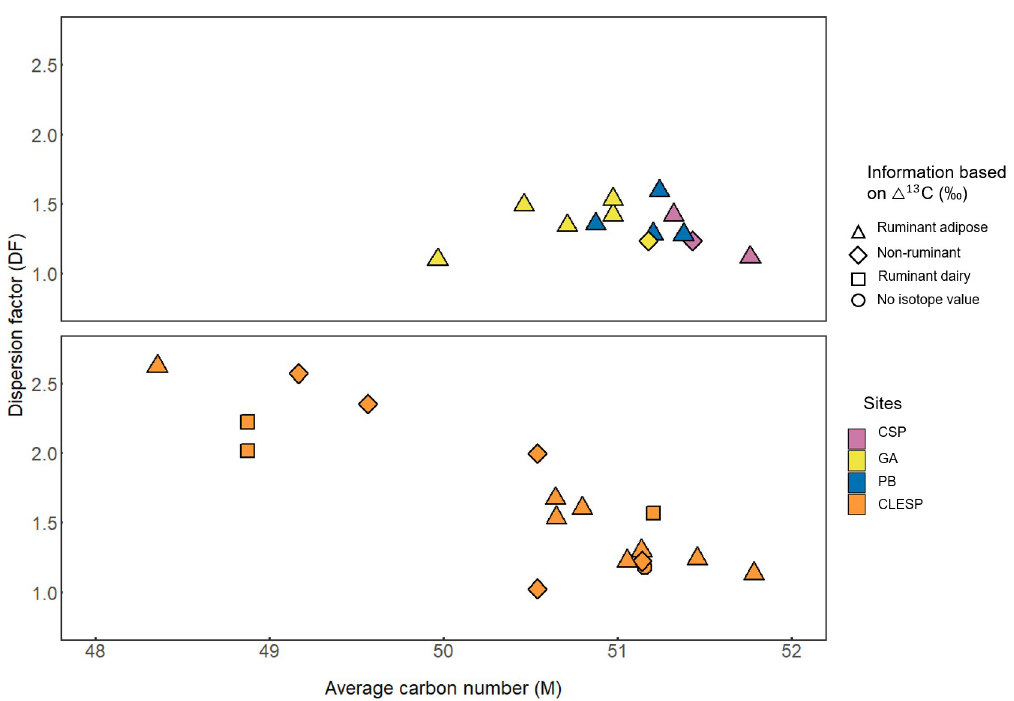
Fig 5. Plots of TAG information based on HT-GC data of individual pottery samples from Palermo sites (CSP, GA and PB) and Castronovo (CLESP) with interpretations based on fatty acid isotope values. The dispersion factor (DF) and average carbon number (M) were calculated using statistical equations outlined by Mirabaud et al. [52]. Shapes represent ruminant dairy ( ● ) based on Δ 13 C values < -3.3‰, ruminant adipose ( ◆ ) based on Δ 13 C values between -3.3‰ and -1.0 ‰ and non-ruminant ( ■ ) based on Δ 13 C above -1.0‰